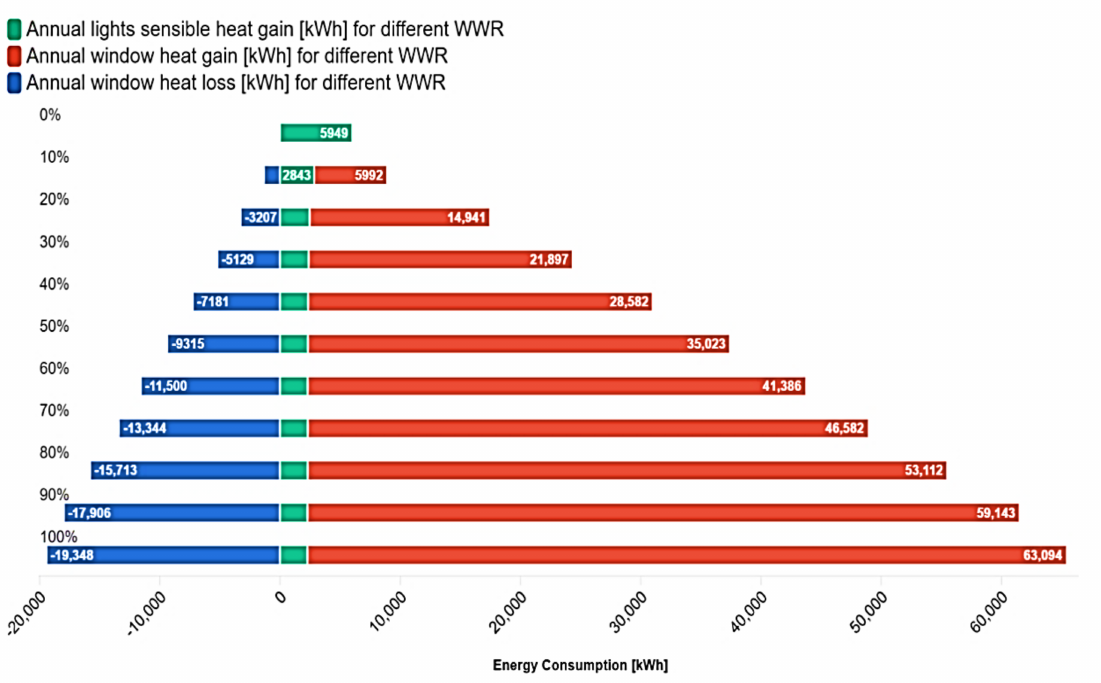
red and green bars denote the yearly heat gain from windows and lighting, respectively, whereas yearly heat loss via windows is depicted by the blue bars.